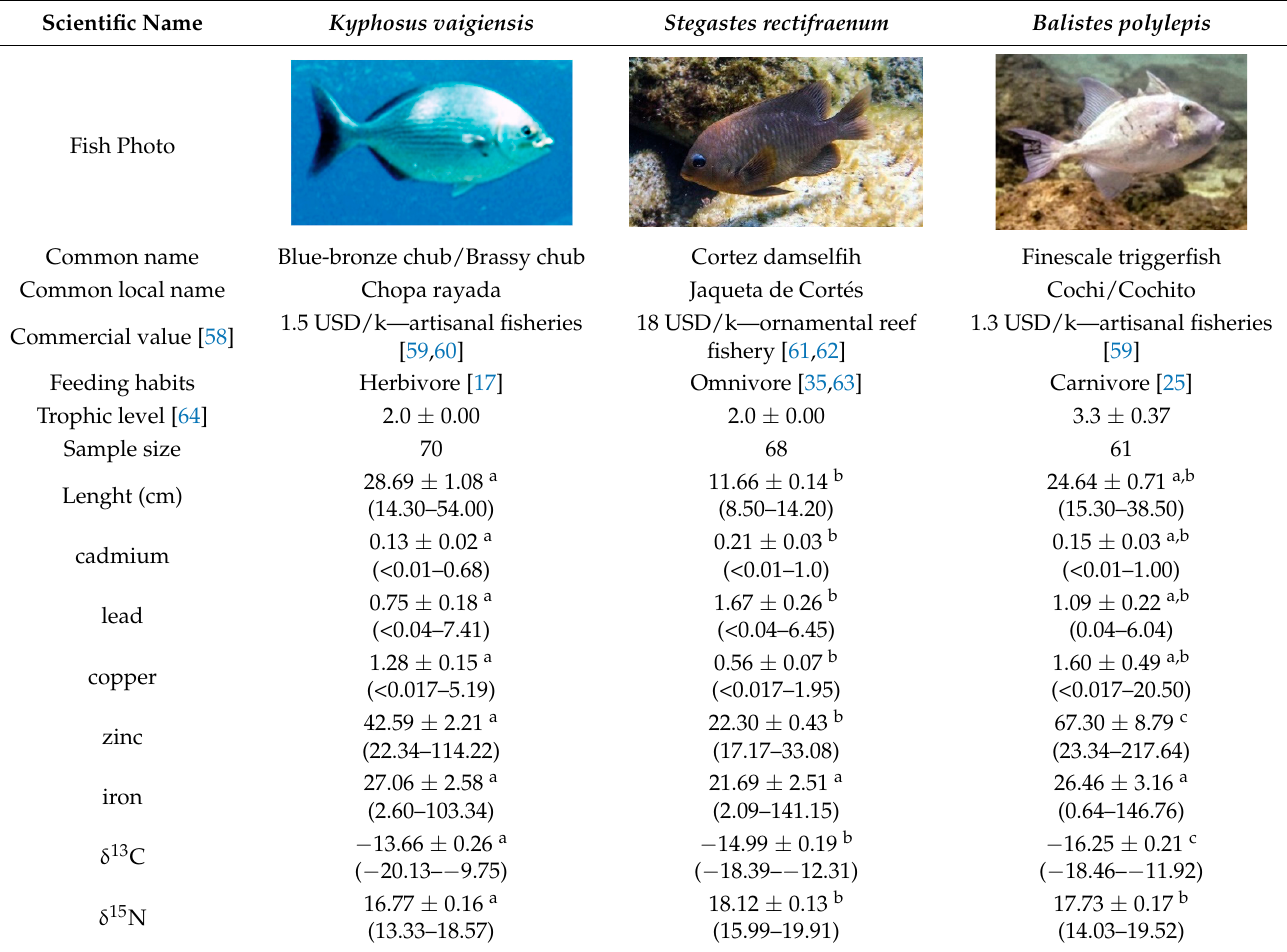
Table 3. General characteristics, body length (cm), metal concentrations (µg g − 1 ; dw), δ 15 N and δ 13 C (‰) in muscle of three fish species. Data are shown as mean ± SE (minimum–maximum).